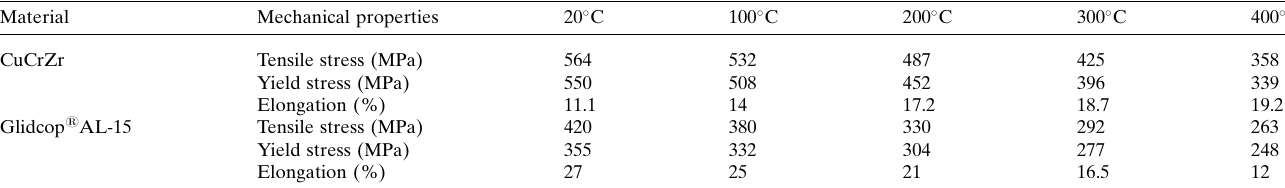
Table 2 Mechanical properties of CuCrZr and Glidcop 1 AL-15.